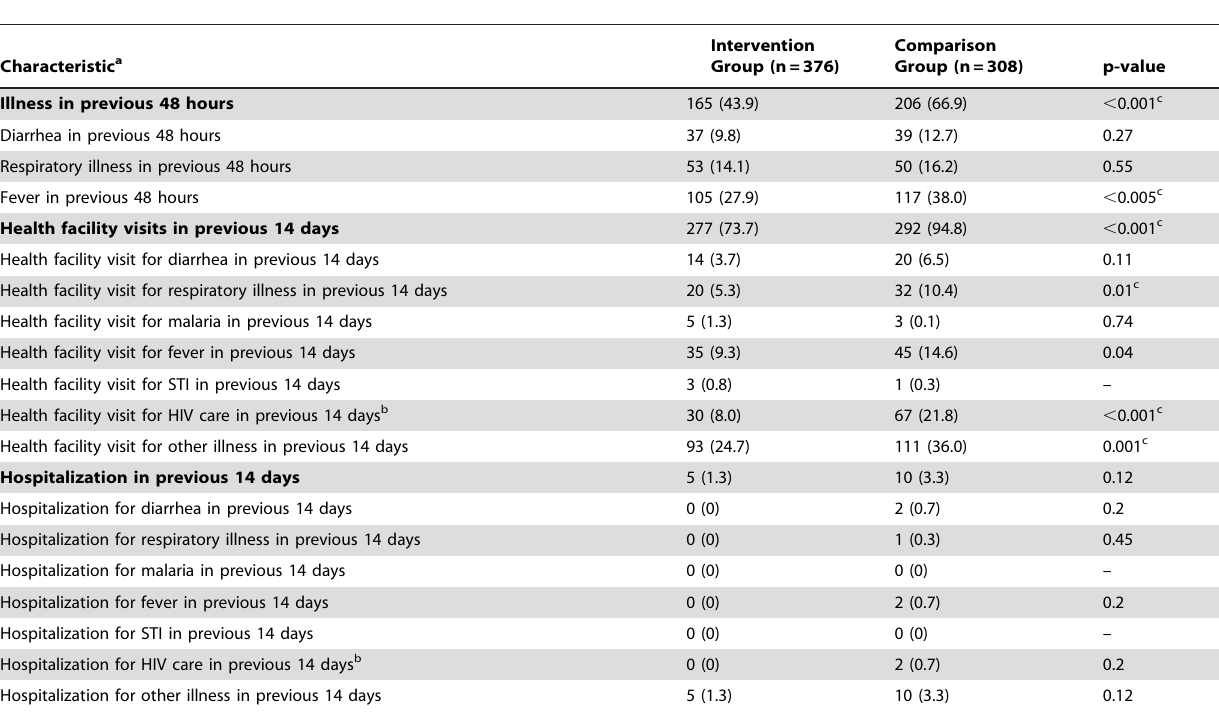
Table 4. Percent of clients self-reporting one or more episodes of illness, health facility visit, and hospitalization by intervention and comparison group, over 16 weeks of basic care package evaluation, Gonder and Debre Markos, Ethiopia, October 2009– January 2010.